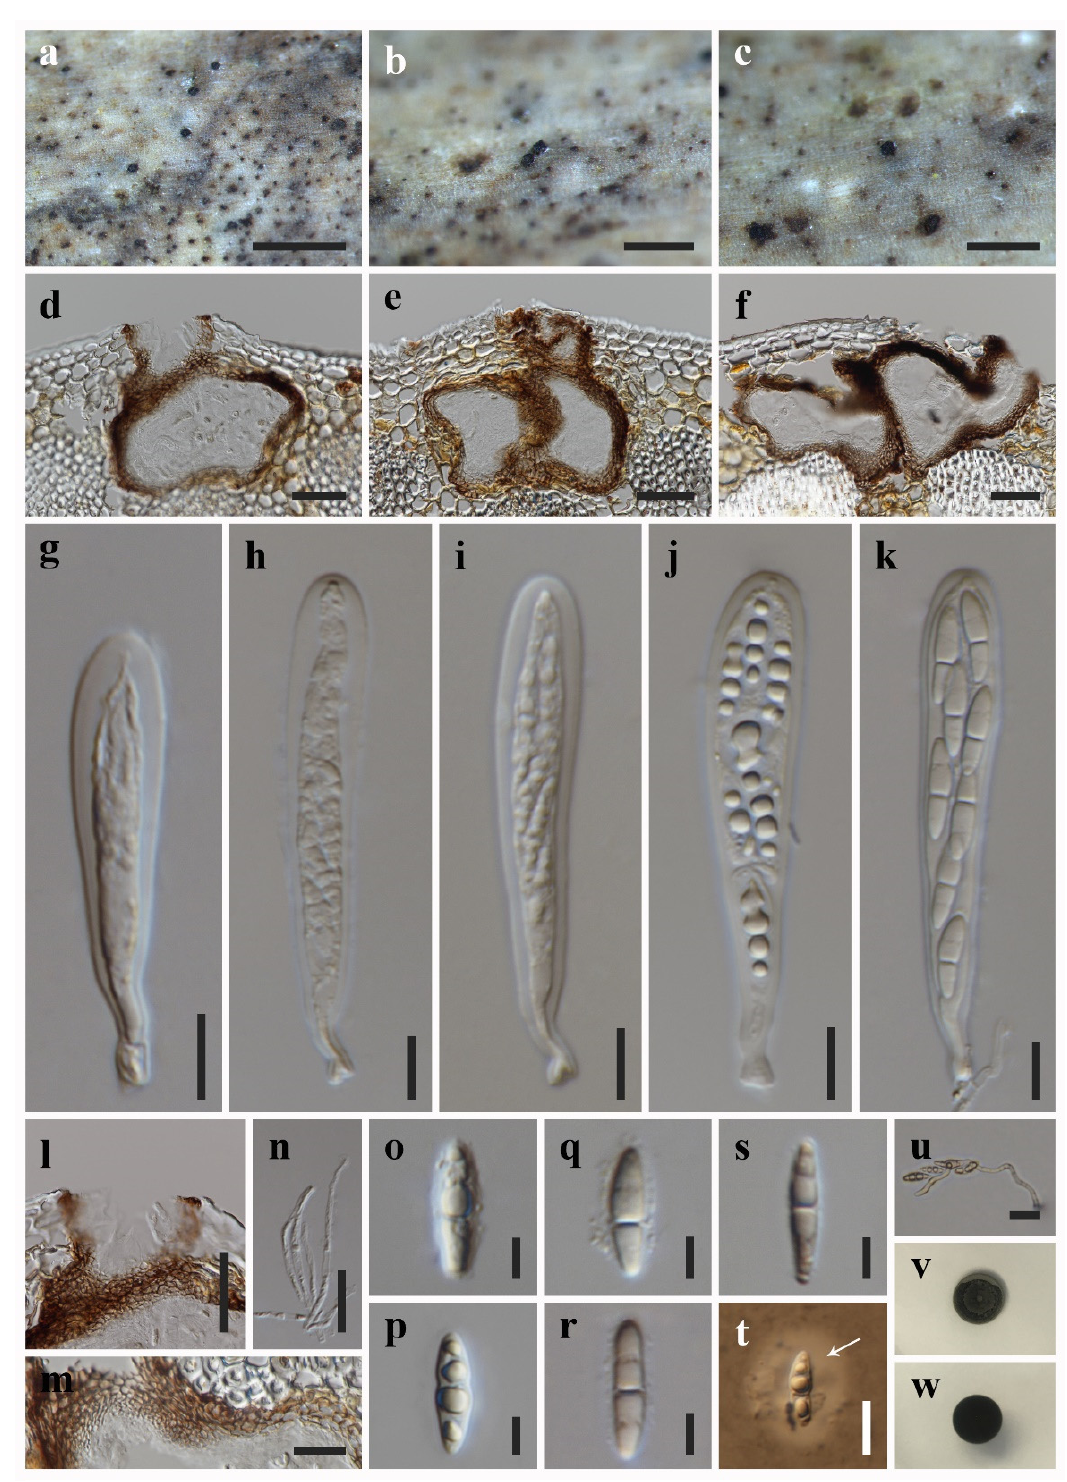
Figure 4. Neooccultibambusa trachycarpi (HKAS 113020, holotype ) ( a – c ) Ascomata on host substrate. ( d – f ) Vertical section of ascoma. ( g – k ) Asci. ( l ) Ostiole, showing periphyses. ( m ) Structure of peridium. ( n ) Pseudoparaphyses. ( o – t ) Ascospores (( t ) Arrow indicated mucilaginous sheath). ( u ) Germinated ascospores. ( v , w ) Colonies on PDA, above ( v ), reverse ( w ). Scale bars: ( a , b ) = 1000 μ m, ( c ) = 500 μ m, ( d–f , l ) = 50 μ m, ( g–k , t ) = 10 μ m, ( m , n , u ) = 20 μ m, ( o – s ) = 5 μ m.